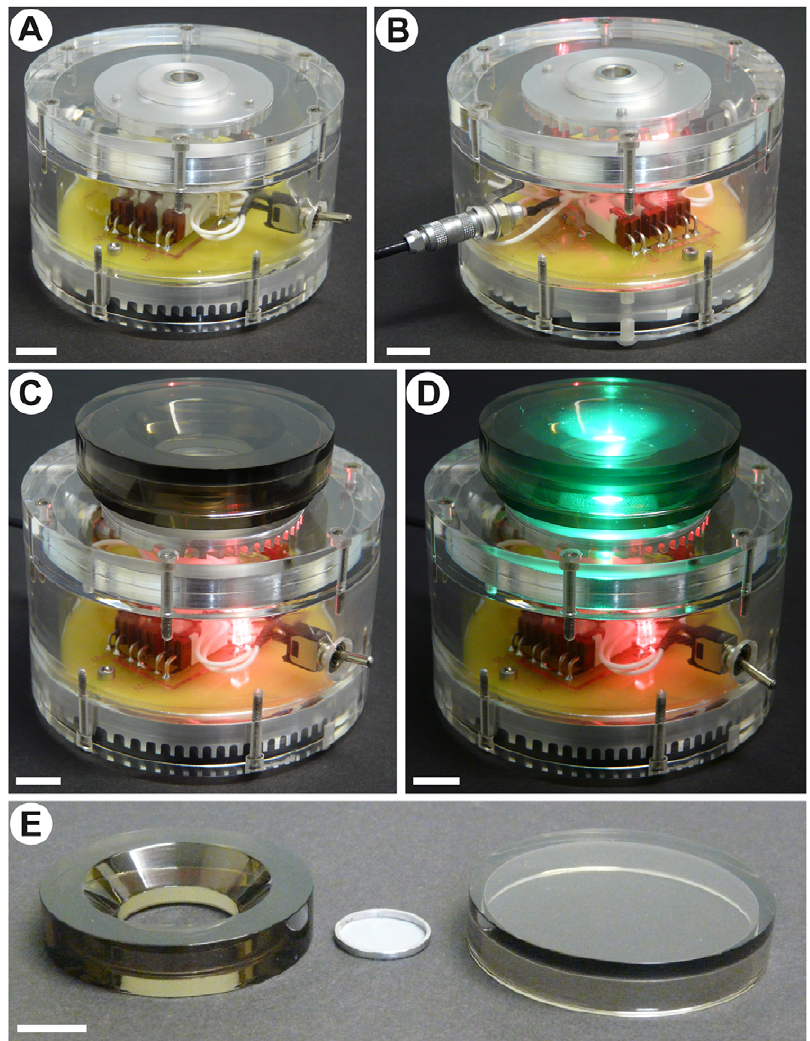
Figure 1. Photooxidizer apparatus and tissue chamber. Scale bars correspond to 10 mm. A: Front view of the apparatus in an offline configuration. B: Rear view of the apparatus. The machine is connected to an outlet, but the switch is turned off. C: View of the photooxidizer with the connected tissue chamber. D: View of the photooxidizer with the connected tissue chamber while the apparatus is turned on. Note that the chamber fits over the LED light beam. E: Disassembled tissue chamber, including the acrylic ring, the glass lid and the aluminum ring with nylon mesh used for holding the tissue in place.